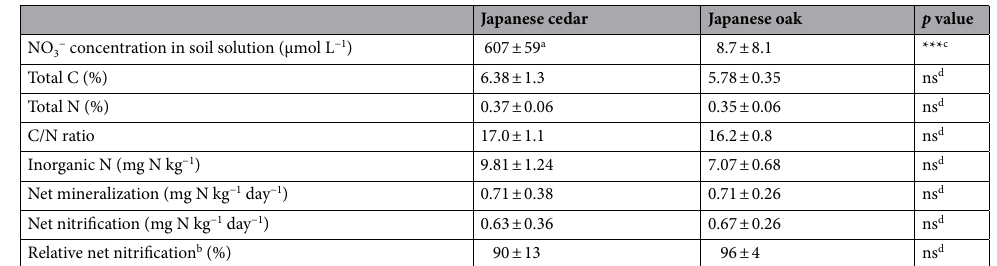
Net nitrification (mg N kg −1 day −1